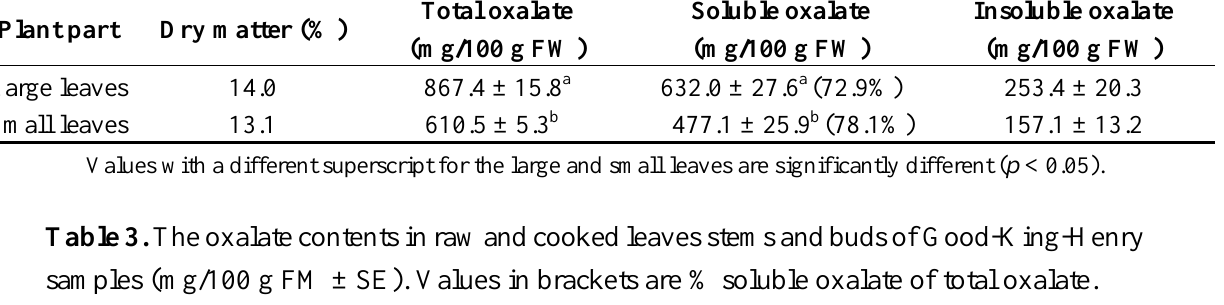
Table 2. The oxalate contents in raw large and small leaves (mg/100 g fresh weight (FW) ± standard error (SE)).Values in brackets are % soluble oxalate of total oxalate. Plant part Dry matter (%)